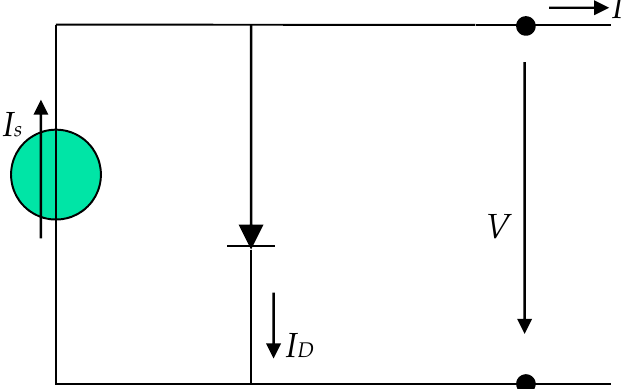
Figure 2. Equivalent circuit of a PV module—one diode and three parameters (1D + 3P) model. The p–n junction performs as a large diode. The fundamental property of a diode is that it conducts electric current in only one direction. When the applied voltage is positive and greater than a certain minimum, then the current flows through the diode. If the volt- age is negative, then the diode does not conduct current, at least until a certain voltage is reached.